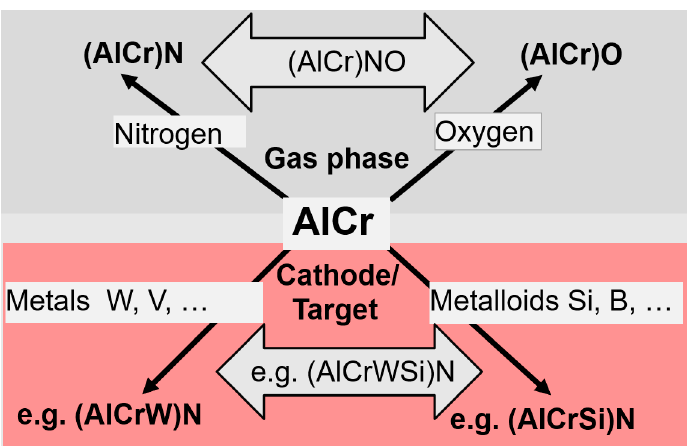
Figure 19. Directions of alloying for (CrAl)N and (AlCr)N designed to tune selected